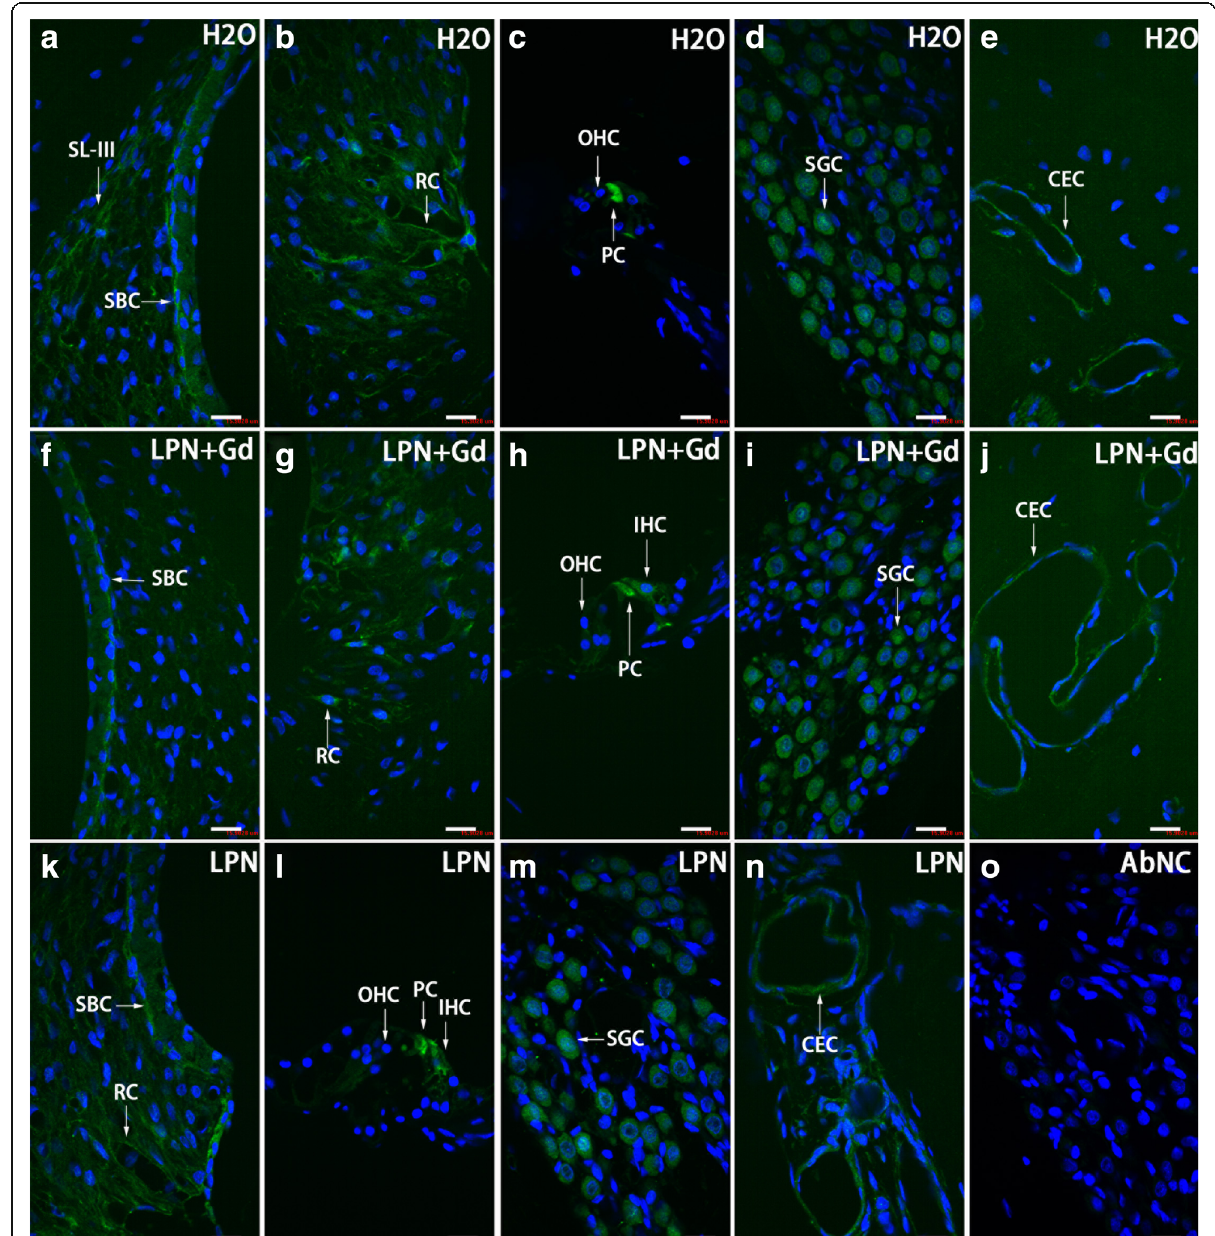
Fig. 11 TLR2-positive cell distribution in the rat cochlea exposed to liposome nanocarrier demonstrated using immunofluorescent confocal microscopy. TLR2-positive cells were mainly detected in the stria basal cell ( SBC ), spiral ligament ( SL ), root cell ( RC ), pillar cell ( PC ), spiral ganglion cell ( SGC ), and capillary endothelial cell ( CEC ) in the groups of negative control ( H2O ) ( a – e ), empty liposome nanocarriers ( LPN ) ( k – n ), and Gd-DOTA-containing LPN ( LPN+Gd ) ( f – j ). There was no staining in the antibody-omitted negative control ( AbNC ) ( o ). IHC inner hair cells, SL-III spiral ligament fibrocyte type III, OHC outer hair cells. Scale bar =16 μ